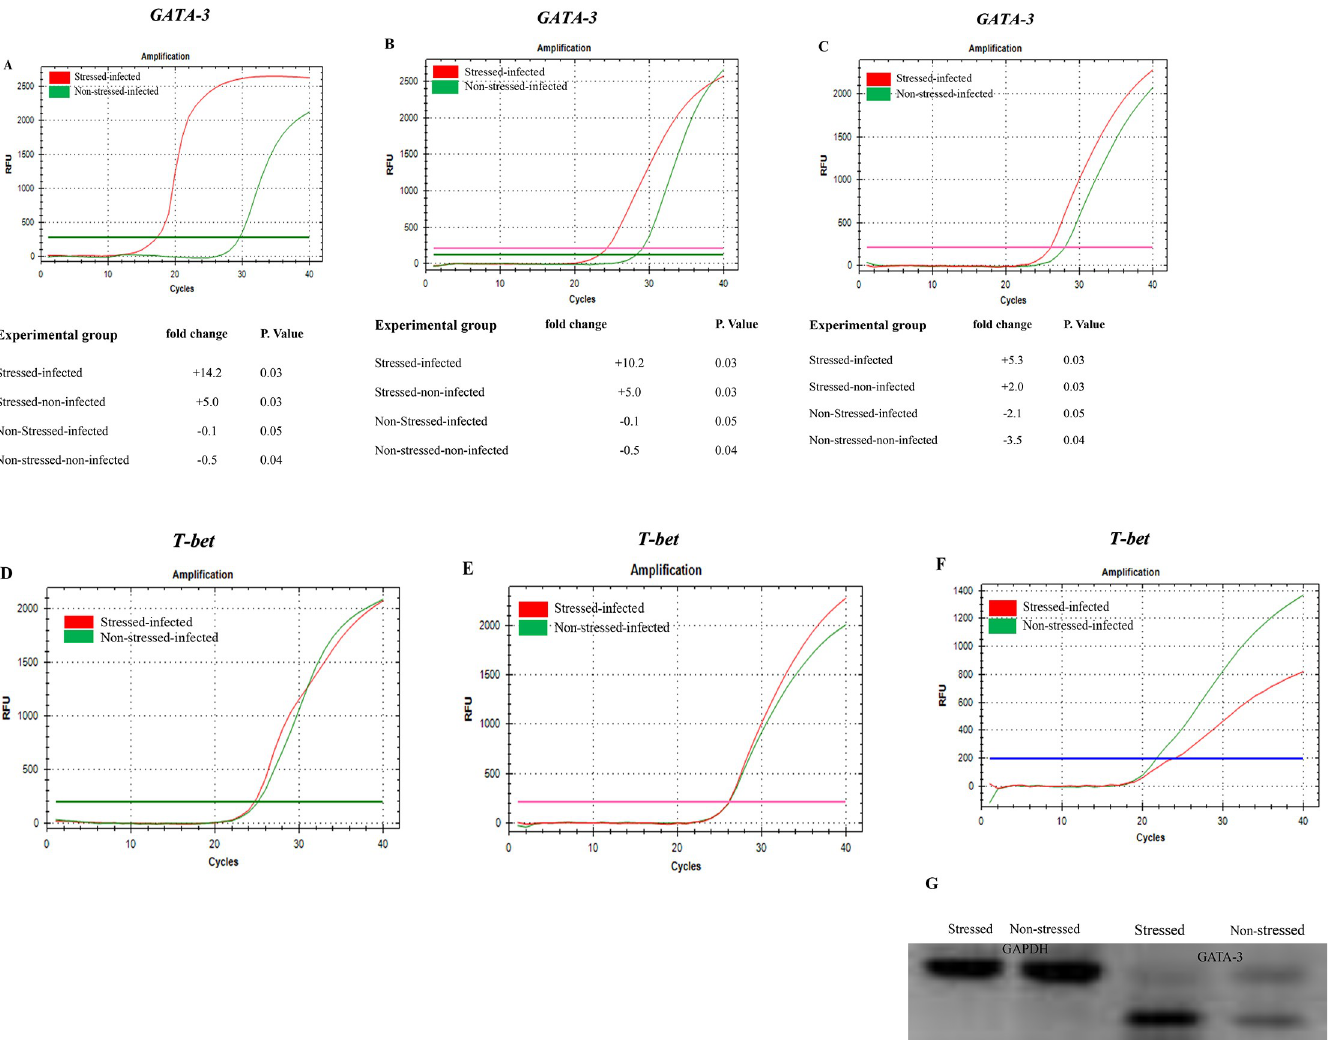
Fig 3. Gene expression profiles of GATA-3 and T-bet in T cells isolated from the whole or the parts of the genital tract of stressed and non-stressed mice during Chlamydia muridarum genital infection. Amplification cures and fold-changes of mRNA levels of transcription factors of T cells isolated A ) whole genital tract, B ) uterus horns, C ) oviduct, D ) T-bet in T cells of the whole genital tract, E ) uterus horns F oviduct), and G ) gel electrophoresis of GATA-3 are shown. Abbs : St = stressed, Non-St = none-stressed. Shown data are representatives of two or more independent